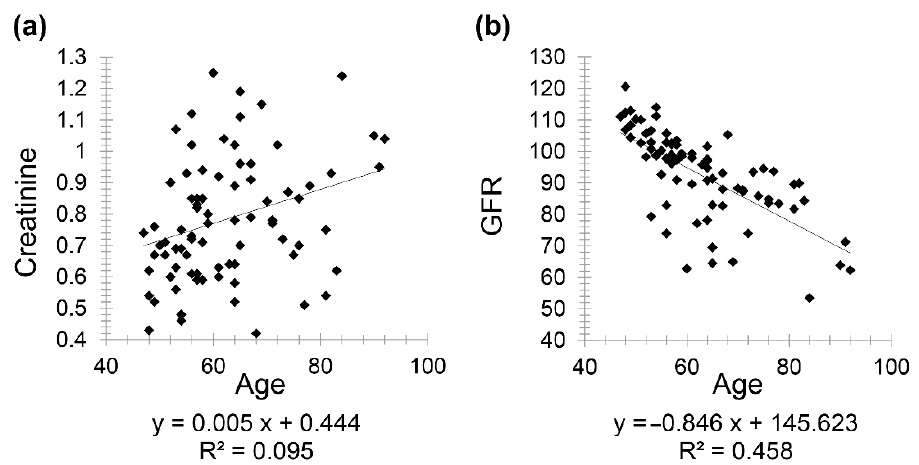
Figure 2. Scatter plot graphs showing ( a ) positive correlation between creatinine and age ( r = 0.308) and (b ) negative correlation between GFR and age ( r = − 0.676) in healthy patients. Diabetic patients (Group 2) included 111 patients (61 females and 50 males) with a mean age of 67.97 for females (minimum 50 and maximum 86) and mean age of 64.78 for males (minimum 47 and maximum 95). There was a very weak negative correlation between HbA1C and age ( r = − 0.031) while a weak positive correlation was seen between kidney volume and HbA1C ( r = 0.063) (Figure 3).